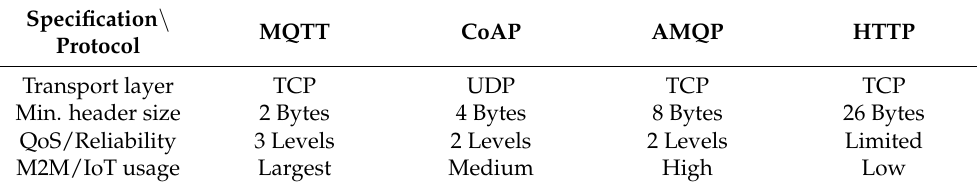
Table 3. Comparison of main ALP for IoT